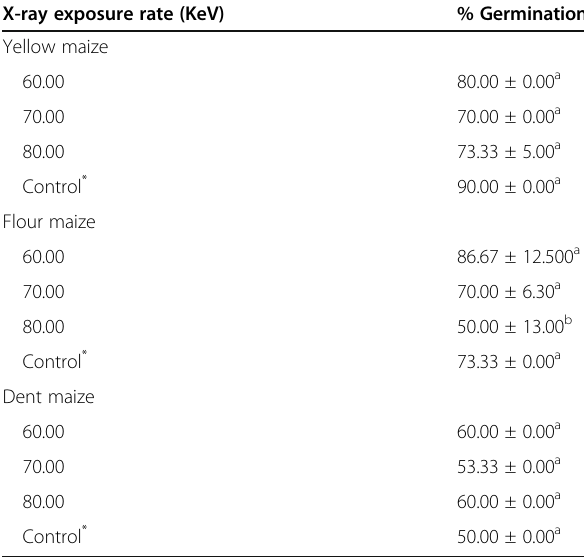
Data are means ± SEM of three replications Mean values in a column with same letter are not significantly different by LSD ( α = 0.05) * Not irradiated with